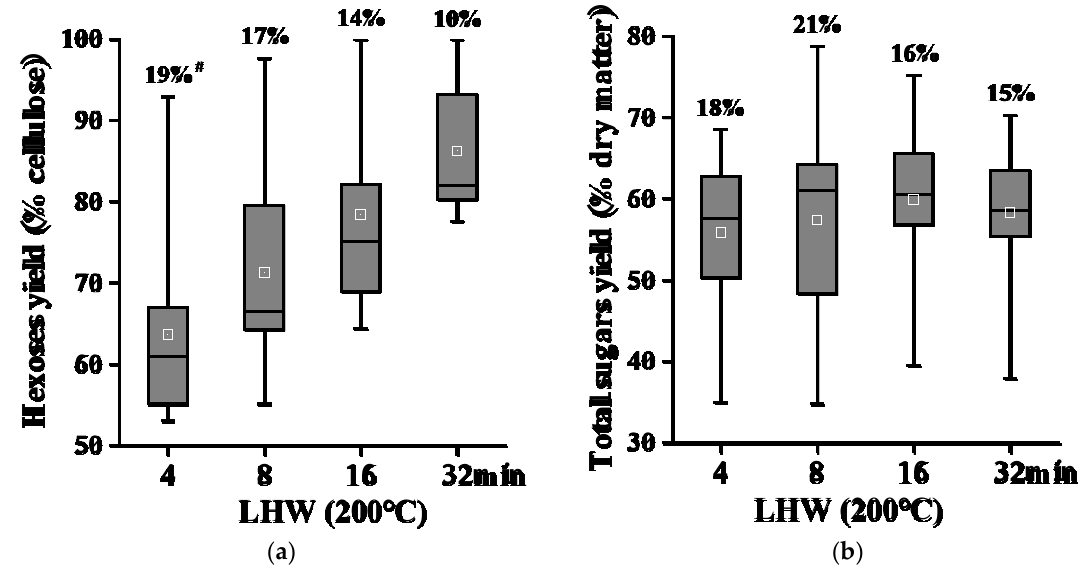
Figure 4. Variation of biomass enzymatic saccharification among 11 total banana samples after liquid hot water (LHW) pretreatments ( n = 11). ( a ) Hexoses yields released from enzymatic hydrolysis after a time course of LHW pretreatments; ( b ) total sugar yields (hexoses and pentoses) released from both enzymatic hydrolysis and a time course of LHW pretreatments; # As coefficient of variation.